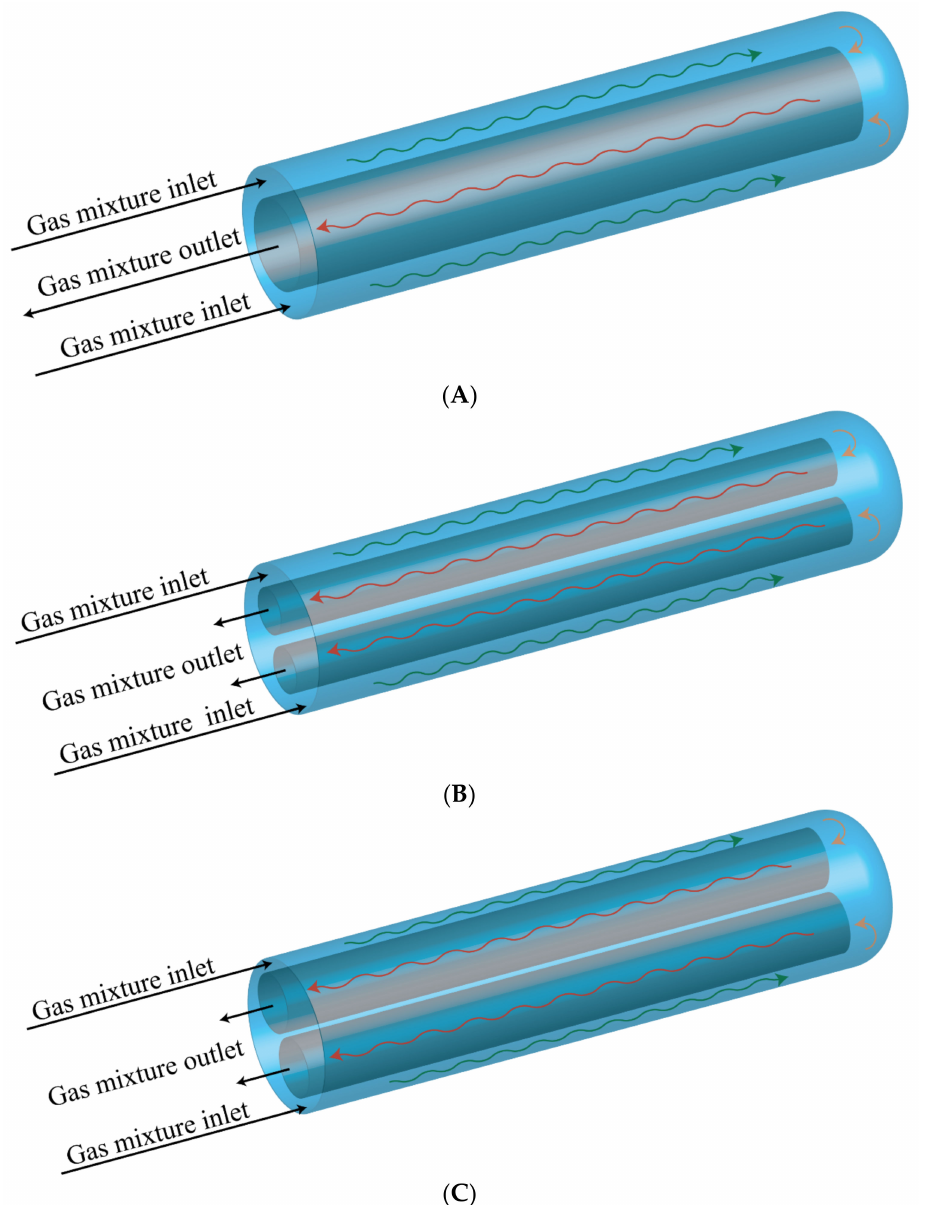
Figure 2. Structural optimization of the catalytic zone of bayonet heat exchanger. ( A ) Structure 1 (inner tube diameter: 0.05 m, heat exchange area: 0.047 m 2 , catalyst volume: 0.00177 m 3 ). ( B ) Structure 2 (inner tube diameter: 0.025 m, heat exchange area: 0.047 m 2 , catalyst volume: 0.00206 m 3 ). ( C ) Structure 3 (inner tube diameter: 0.025 m, heat exchange area: 0.067 m 2 , catalyst volume: 0.00177 m 3